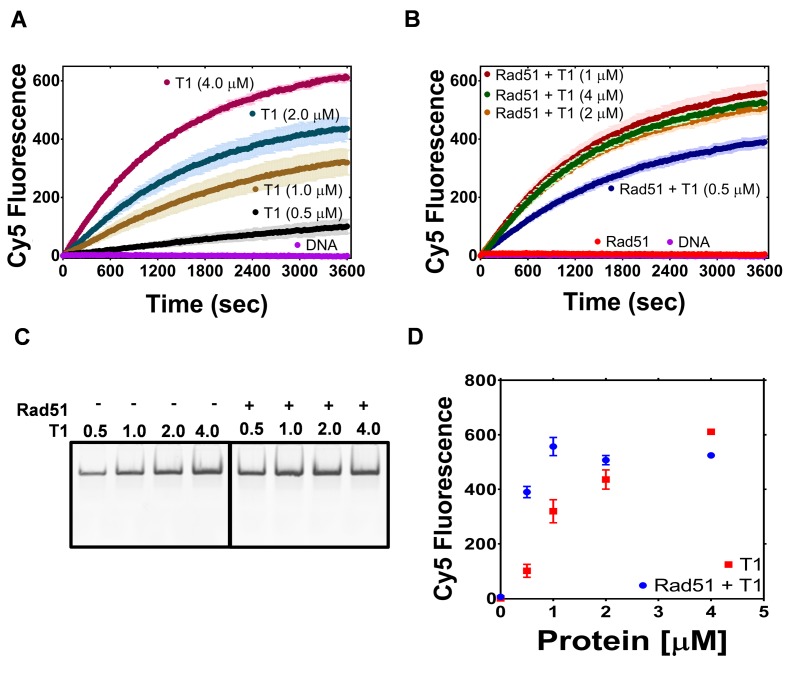
The PALB2 N-DBD stimulates RAD51 strand exchange.(A) Dependence of the strand exchange activity on N-DBD concentration: 0.5 μM (black), 1 μM (brown), 2 μM (navy) and 4 μM (dark red). (B) A reaction similar to (A) in the presence of RAD51 (2 μM, red: without N-DBD). Each point is an average of three measurements in (A) and (B). (C) Deproteinated strand exchange activity products from (A) and (B) separated on native PAGE gel. (D) End-point values of the strand exchange reactions shown in (A) and (B) plotted against N-DBD concentration. Buffer and DNA concentration are identical to those in Figure 4.